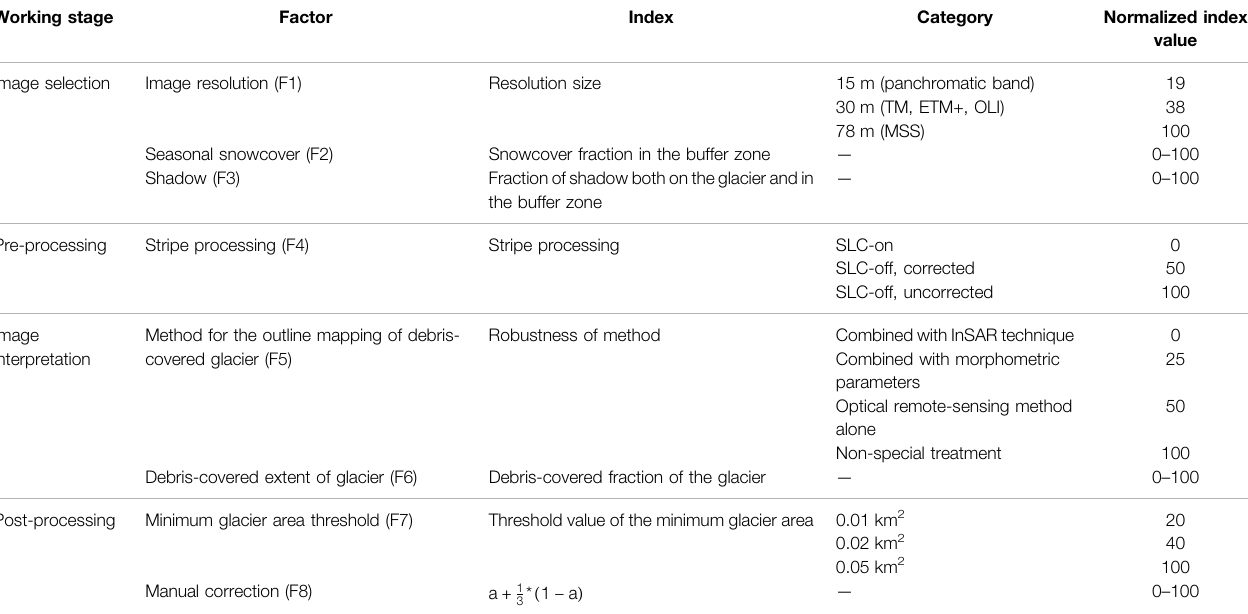
TABLE 3 | Assessment factors and their indexes.